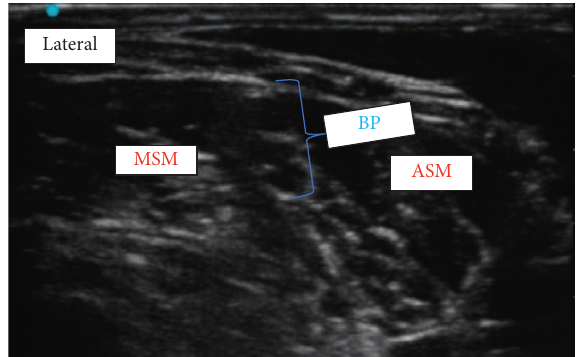
Figure 1: Image of interscalene brachial plexus (BP). The BP is seen positioned between the anterior scalene muscle (ASM) and the middle scalene muscle (MSM). In this particular image, the white arrow represents the needle location for local anesthetic